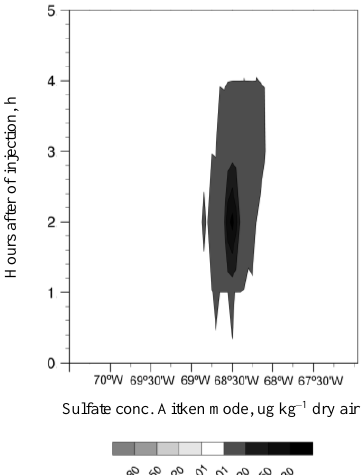
Fig. 10. Time versus longitude section of Aitken-mode SO 42 − concentration anomaly calculated as ID1B − Test_Control at 4 km a.s.l. The analysis is based on concentration averages at 32  54' S (see dotted line in Fig. 1(b)). Fig. 11 shows the spatial distribution of aerosols with the Aitken mode (upper panel) and the Accumulation mode (lower panel) at 4 km a.s.l. for 8 January 2012, estimated through ID3 − Test_Control. The positive values of the image indicate that the aerosol concentrations of the ID3 with Aitken and Accumulation modes exceed the concentrations of the same size distribution modes of the control test. Therefore, the image suggests that the SO 4 I emissions of experiment